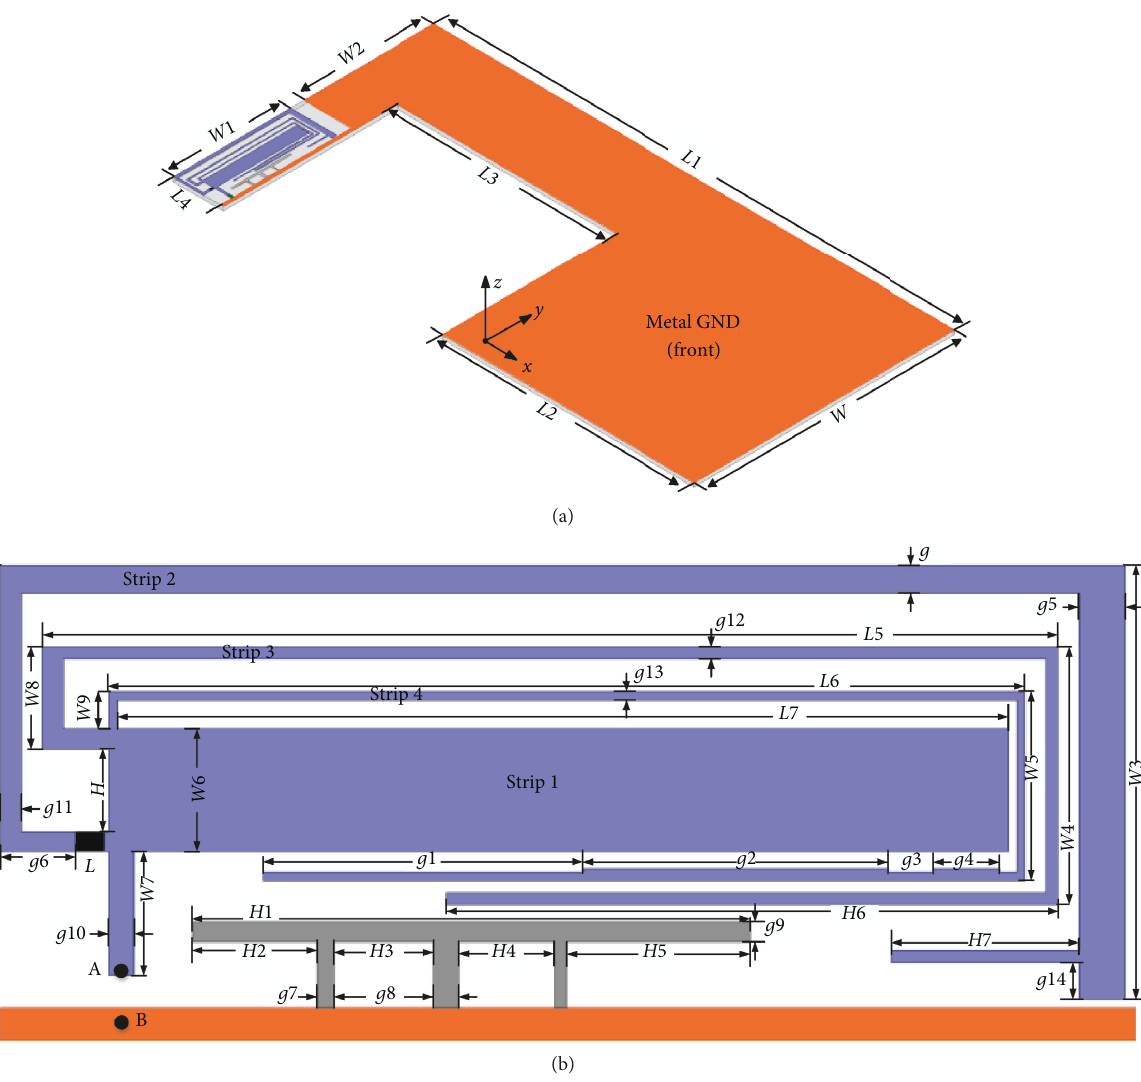
Figure 1: Geometry of the proposed antenna. (a) The overall structure of the proposed antenna and (b) the important part structure of the proposed